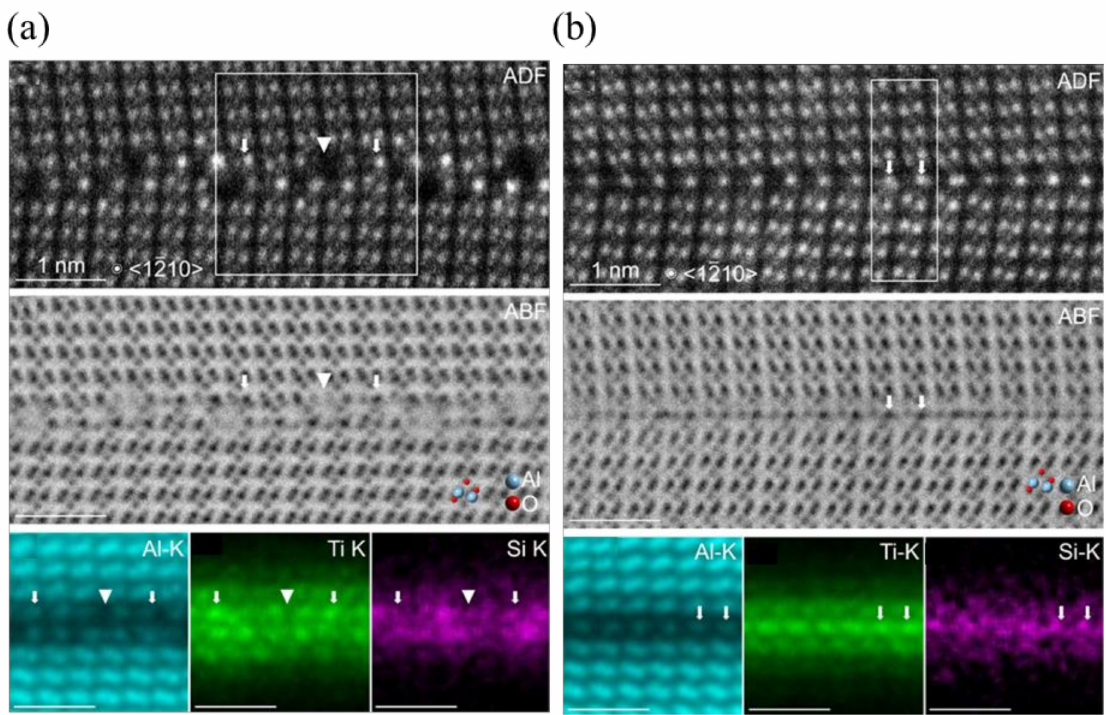
Figure 30. ADF-STEM, ABF-STEM and EDXS count maps of Al-K, Ti-K, and Si- K edges, respectively, obtained from ( a ) type-I and ( b ) type-II Ti-doped Σ 13 α -Al 2 O 3 GBs viewed along the image indicates the size of the unit structure of pristine GB. The arrows indicate the positions of brighter Z-contrast in the GB core, and corresponding locations are also indicated in respective images. All the scale bars are 1 nm. Reprinted from [222] under the terms of the Creative Commons CC BY